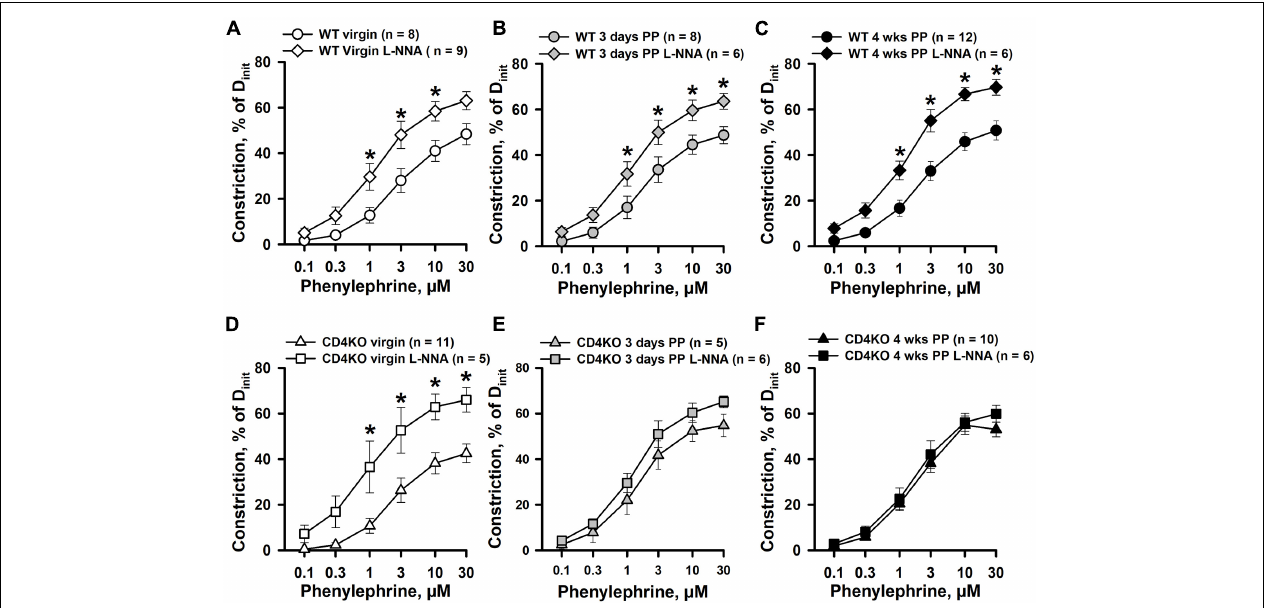
FIGURE 4 | The effects of nitric oxide synthase (NOS) inhibition with L-NNA on phenylephrine (PE)-induced constrictor responses of internal carotid arteries from C57BL/6 wild-type (WT) and CD4 T cell deficient (CD4KO) virgin and postpartum (PP) mice. (A–C) Summary graphs showing that blockade of NO production with L-NNA resulted in a significant enhancement of PE-induced constriction of arteries from virgin (A) , 3 days (B) , and 4 weeks (C) PP WT mice (* P < 0.05, two way RM ANOVA). (D) PE-induced responses of ICAs from CD4KO virgin mice were significantly increased by L-NNA treatment (* P < 0.05, two way RM ANOVA). Inhibition of NO production with L-NNA did not alter PE-induced responses of arteries from 3 days (E) and 4 weeks (F) PP CD4KO mice ( P > 0.05, two way RM ANOVA).